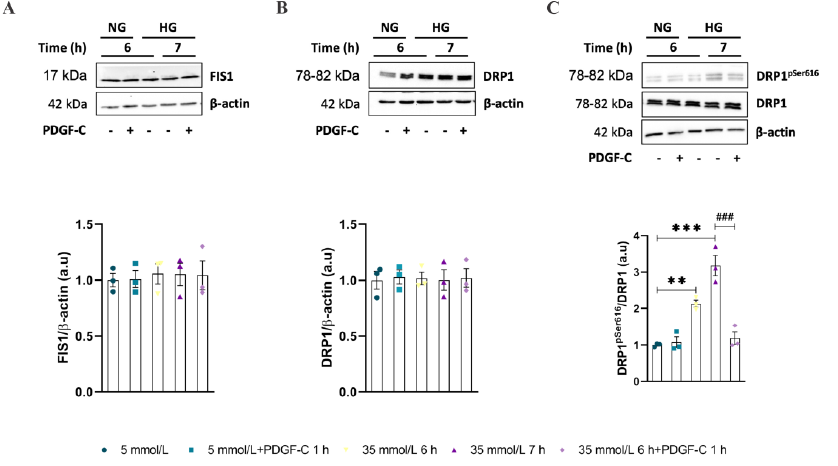
Figure 3. Effect of PDGF-C on fission-related proteins in HAECs exposed to high glucose. Cells were seeded in 6 well plates and exposed to 35 mmol/L d-glucose for 6 and 7 h without and with 50 ng/mL PDGF-C for 1 h, and ( A ) FIS1 and ( B ) DRP1 expression and the ratio between ( C ) DRP1 pSer616 /DRP1 were evaluated by western blot. Images correspond to representative blots for each protein. Densitometry analysis corresponds to the band of each protein normalized with the band of β -actin and DRP1 for phosphorylation residue. Data represent the mean ± SEM of at least three independent experiments. (** p < 0.01, *** p < 0.001, ### p < 0.05 regarding